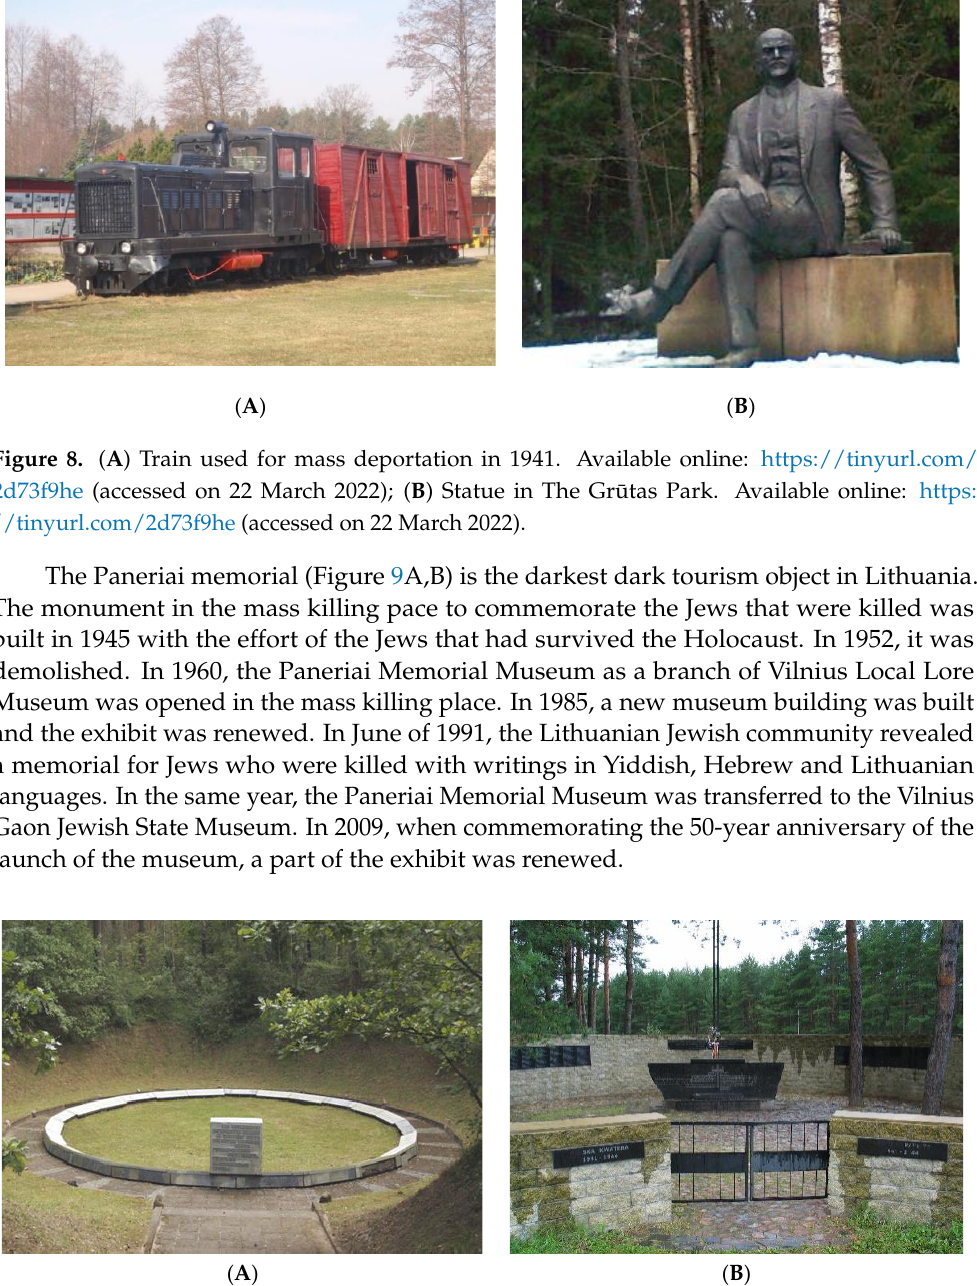
Figure 8. Train used for mass in 1941.